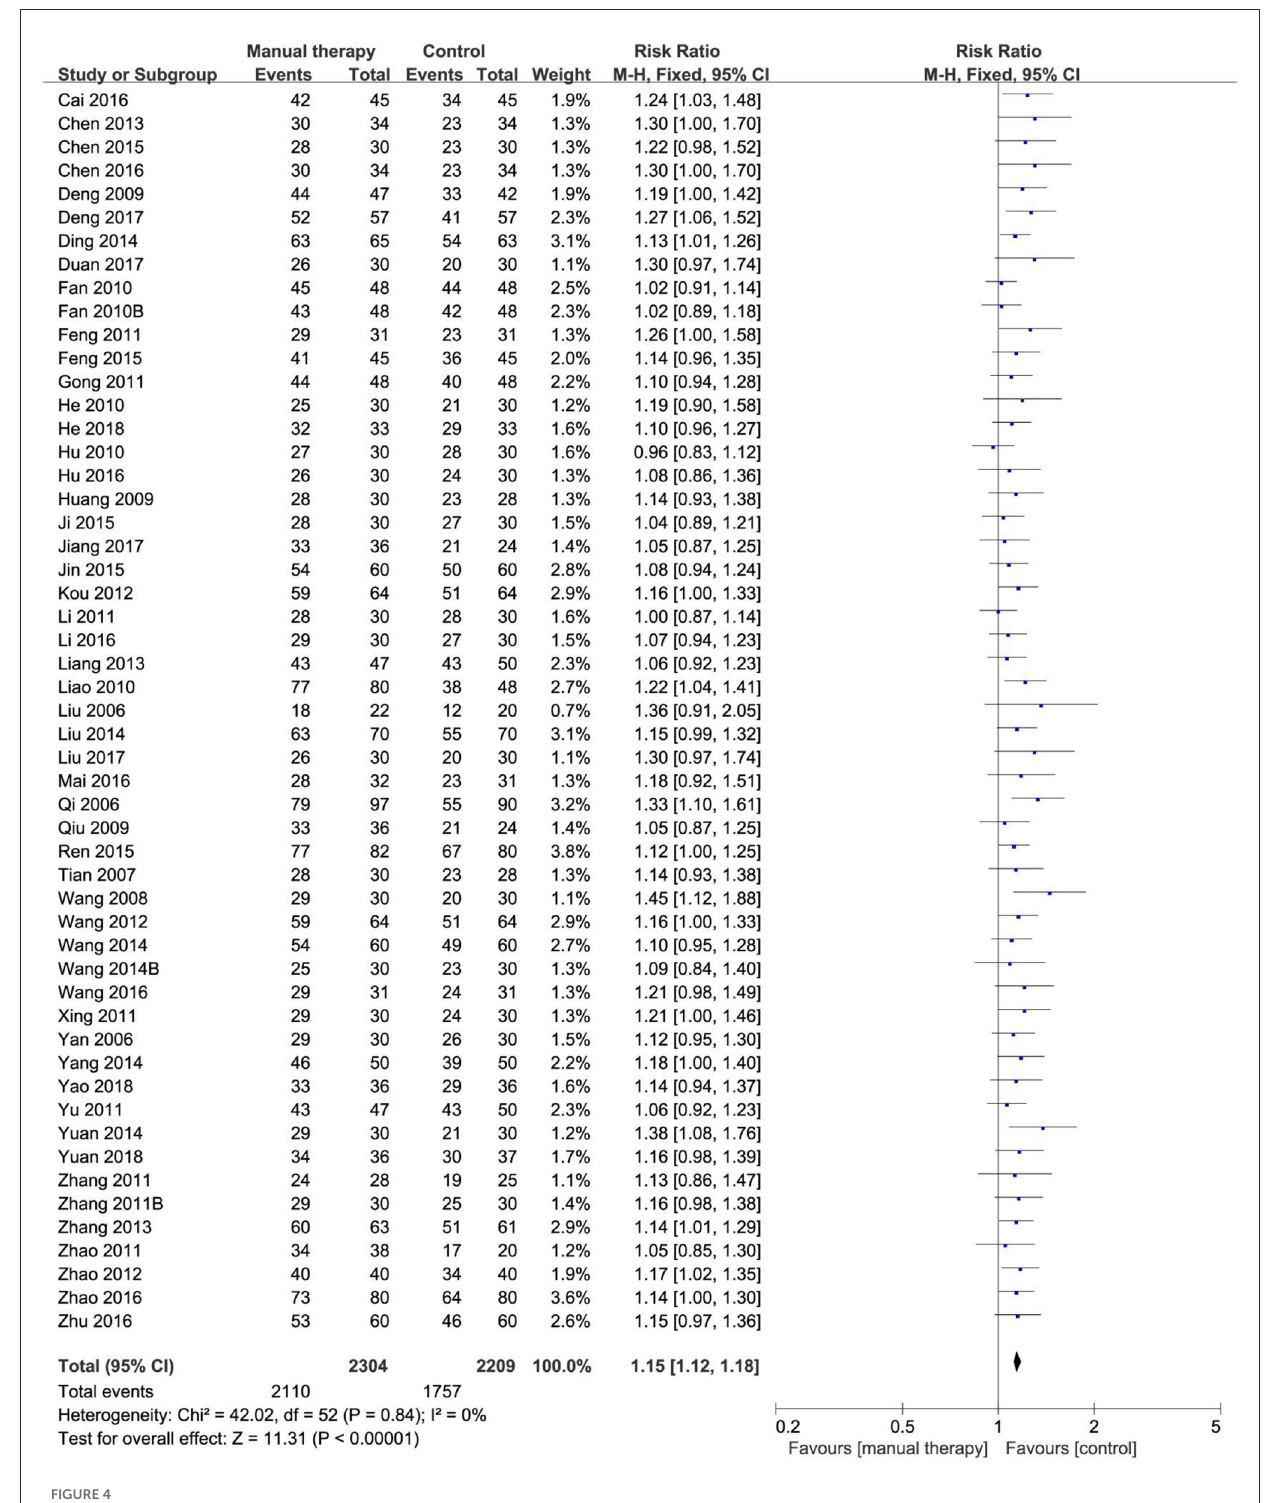
FIGURE4 Forest plot of total effective